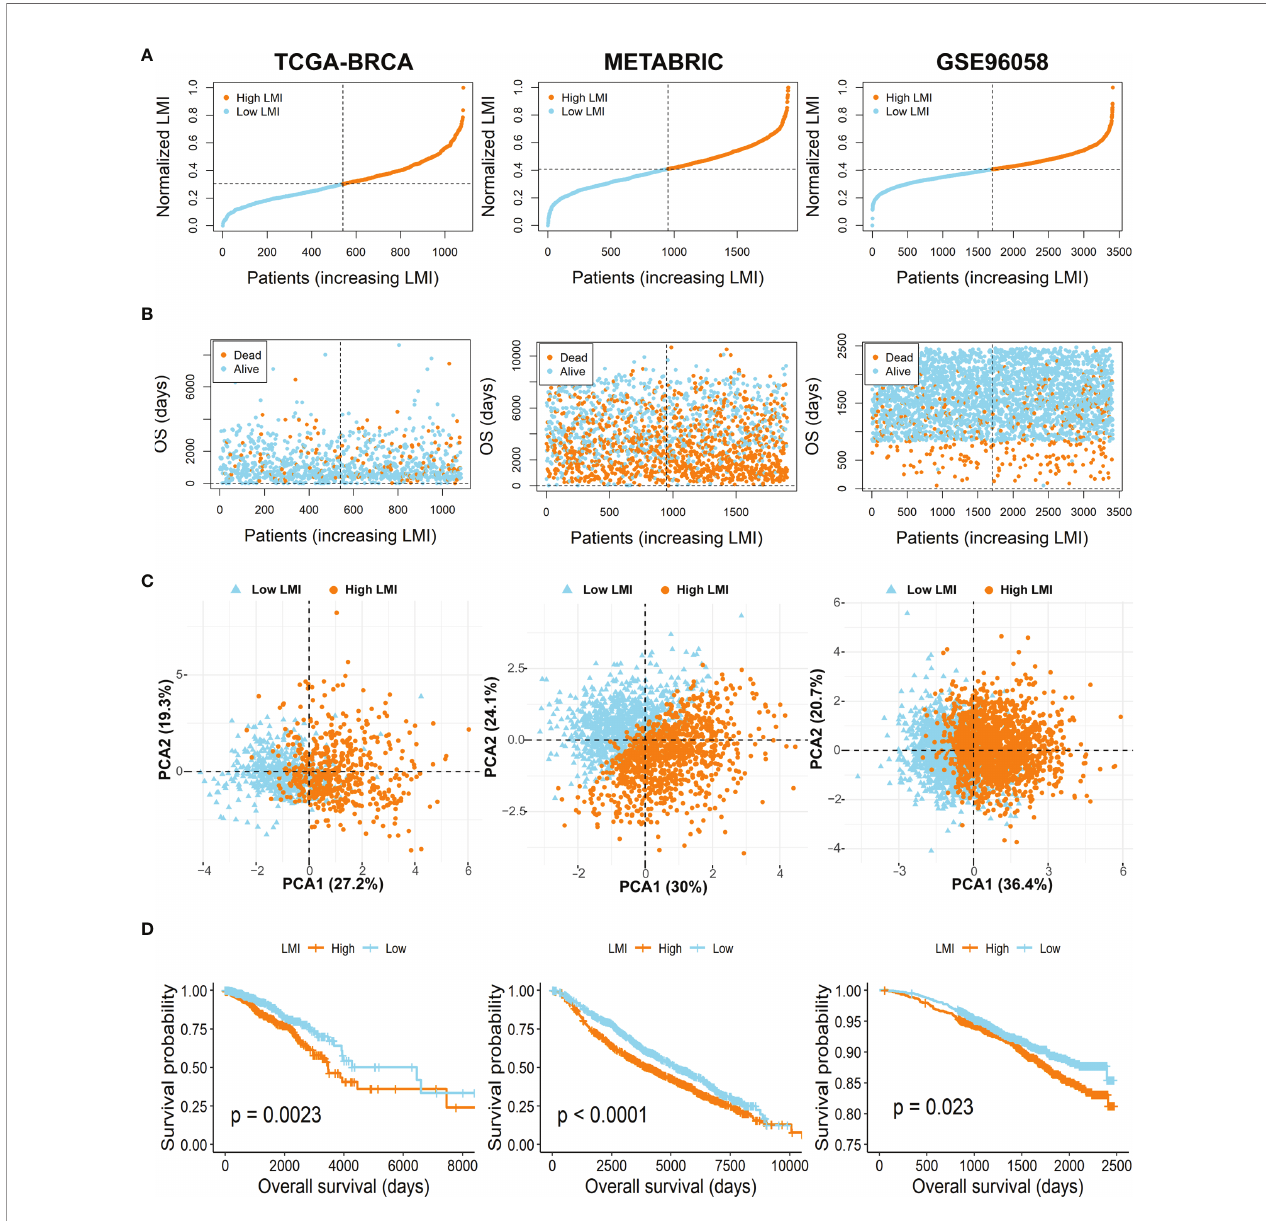
FIGURE 3 | Evaluation and validation of the feasibility of LMI in training set and validation sets. (A) Distribution of the patients ’ adjusted LMI score. (B) BC patients ’ OS time along with their LMI score. (C) PCA analyses of high- and low-LMI groups. (D) KM curves for the OS of BC patients between high- and low-LMI